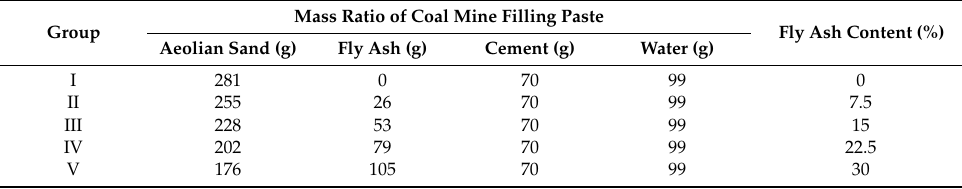
Table 4. Proportion of aeolian sand-fly ash-based filling